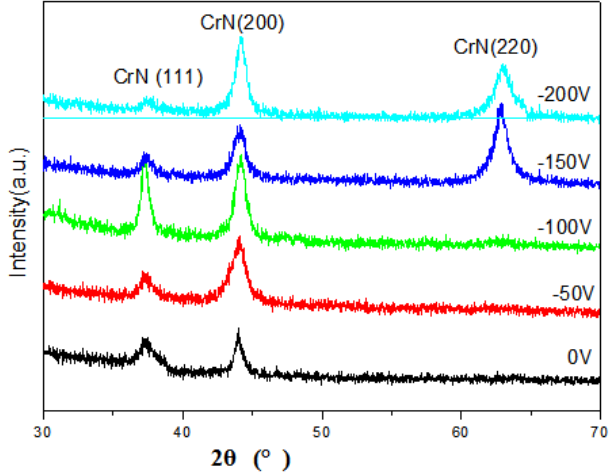
Figure 2. XRD spectra of Cr–Si–N coatings deposited under di ff erent bias voltages.